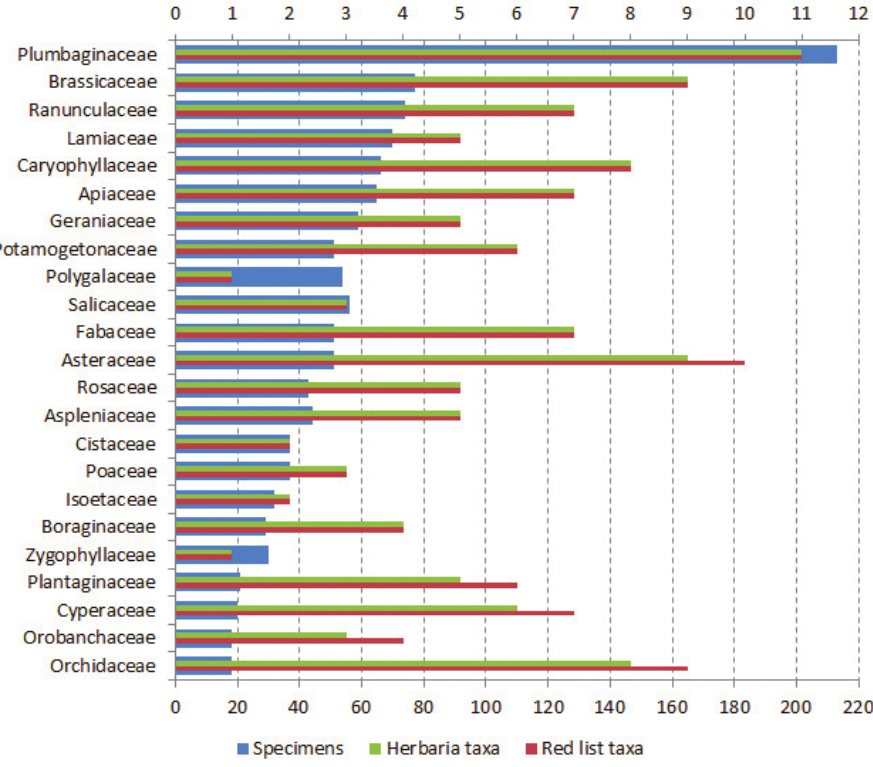
Figure 3. Families with 18 or more specimens (number of the taxa in the upper axis and number of specimens in the lower